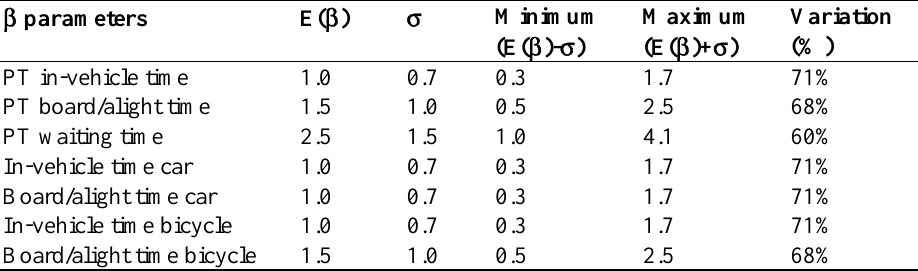
Table 1 Adopted Values for the β